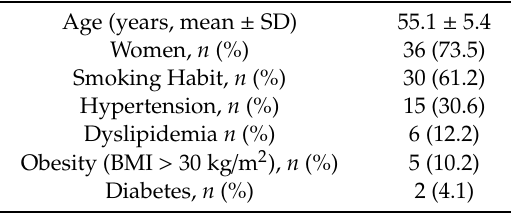
Table 1. Baseline characteristics of all patients ( n = 49).